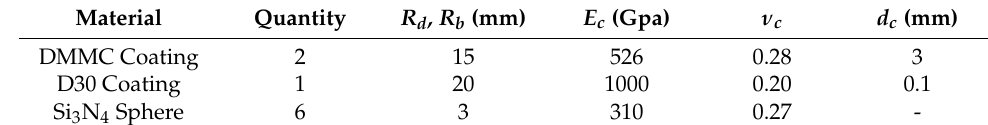
Table 2. Diamond particles dimension distribution on coated disks. Table 1. Sample dimensions and material physical properties of substrates and balls.